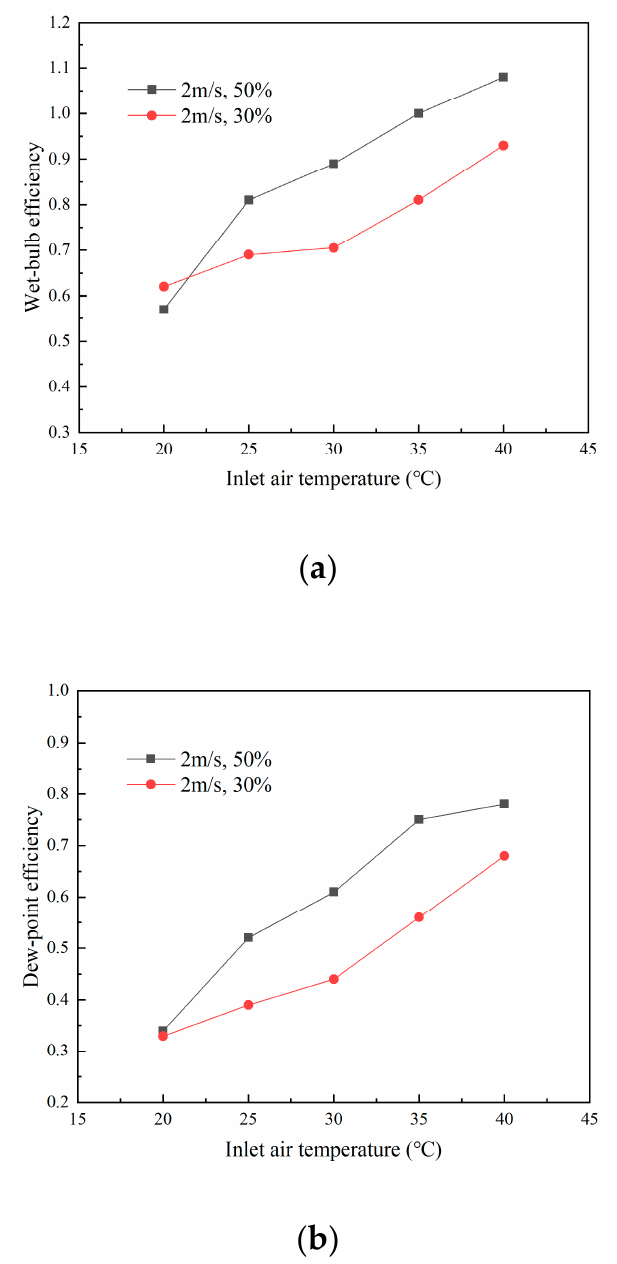
Figure 13. ( a ) Wet-bulb efficiency under different humidity conditions and ( b ) dew-point efficiency under different humidity conditions.